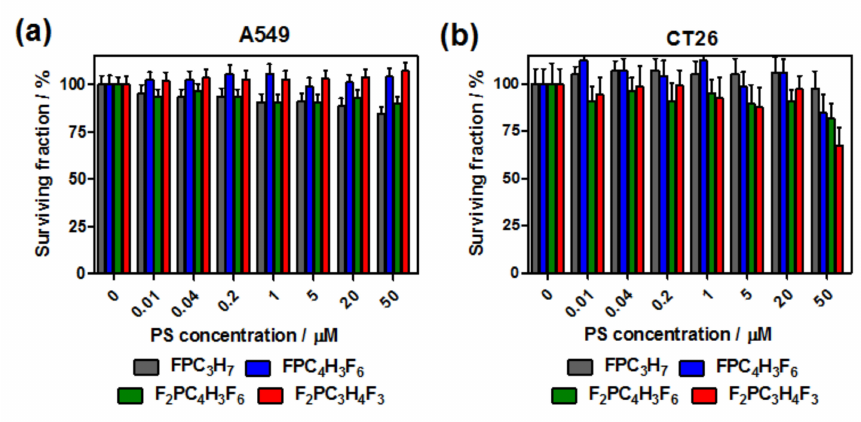
Figure 6. Cytotoxicity of sulfonate ester porphyrins tested in the dark against ( a ) A549 and ( b ) CT26 cancer cells.